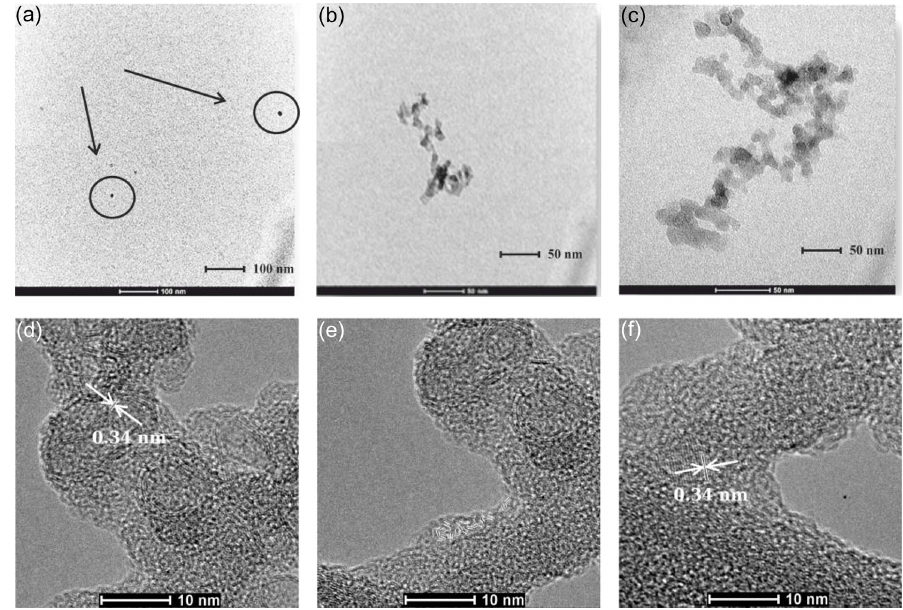
Figure 7. TEM and HRTEM images of various laser-generated carbonaceous aerosol particles. (a) Primary particles obeyed at 0.7Jcm − 2 laser fluence at nitrogen purging gas, (b) and (c) more complicated fractal aggregates gathered at 0.9 and 2.5Jcm − 2 laser fluences in nitrogen purging gas respectively. In (d) – (f) typical microstructure of the generated particles are shown (see text in details).